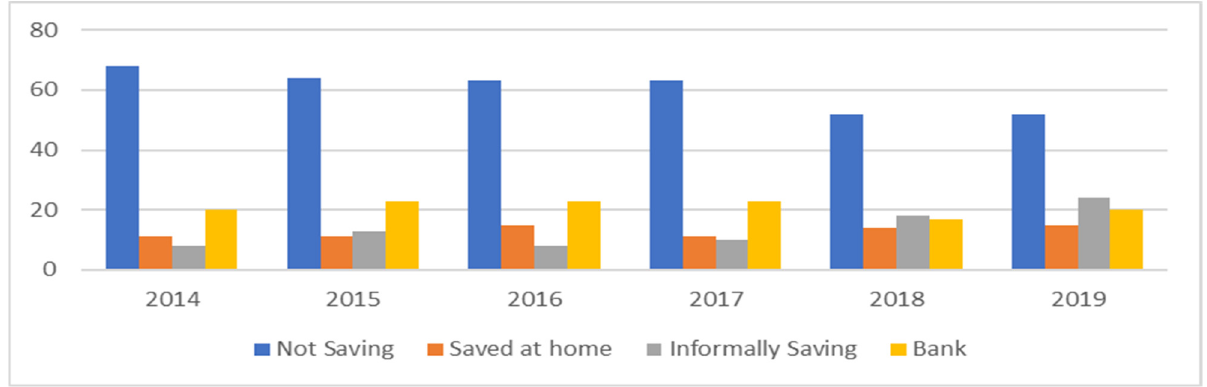
Figure 5. Savings patterns 2014–2019. Source: (FinMark Trust 2018, 2020).